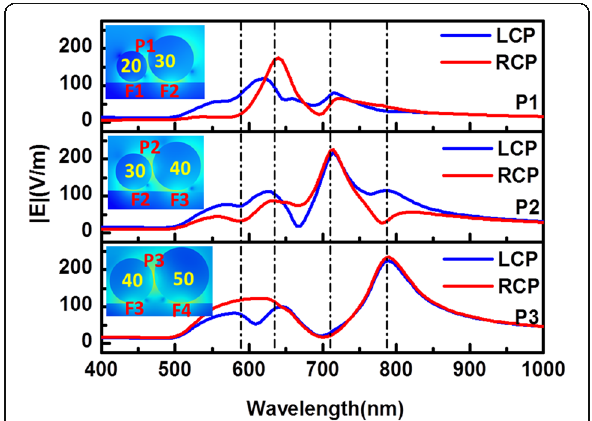
Fig. 4 The electric field enhancement in the gaps P1, P2, and P3 (as indicated in the insets) between different silver particles in the chiral particle chain. The blue and red solid lines represent the electric field enhancement spectra for LCP and RCP light, respectively. The vertical dashed lines from left to right correspond to the peaks at 590, 635, 710, and 785 nm,